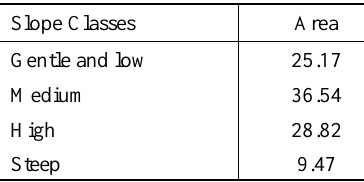
Table 4. Areal distribution (%) of slope classes